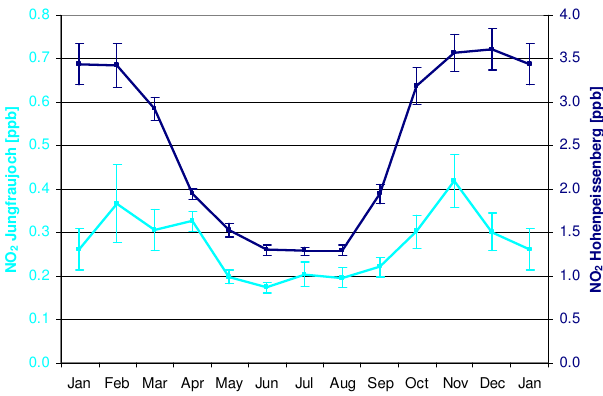
Fig. 12. NO 2 mean annual variation at the “DACH” sites; dark blue: HPB; light blue: JFJ. Error bars indicate the mean error of the Error bars indicate the mean error of the mean. 3